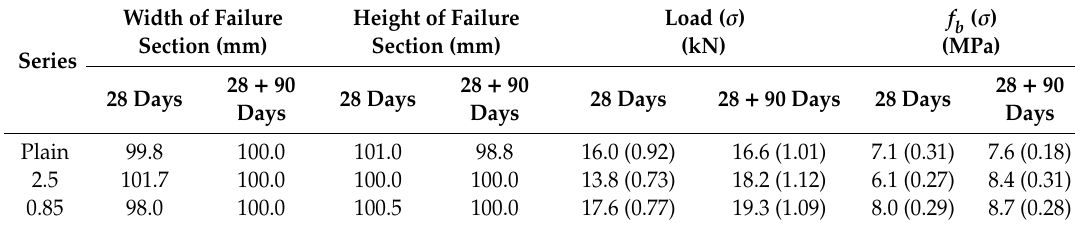
Table 7. Flexural test results of concrete